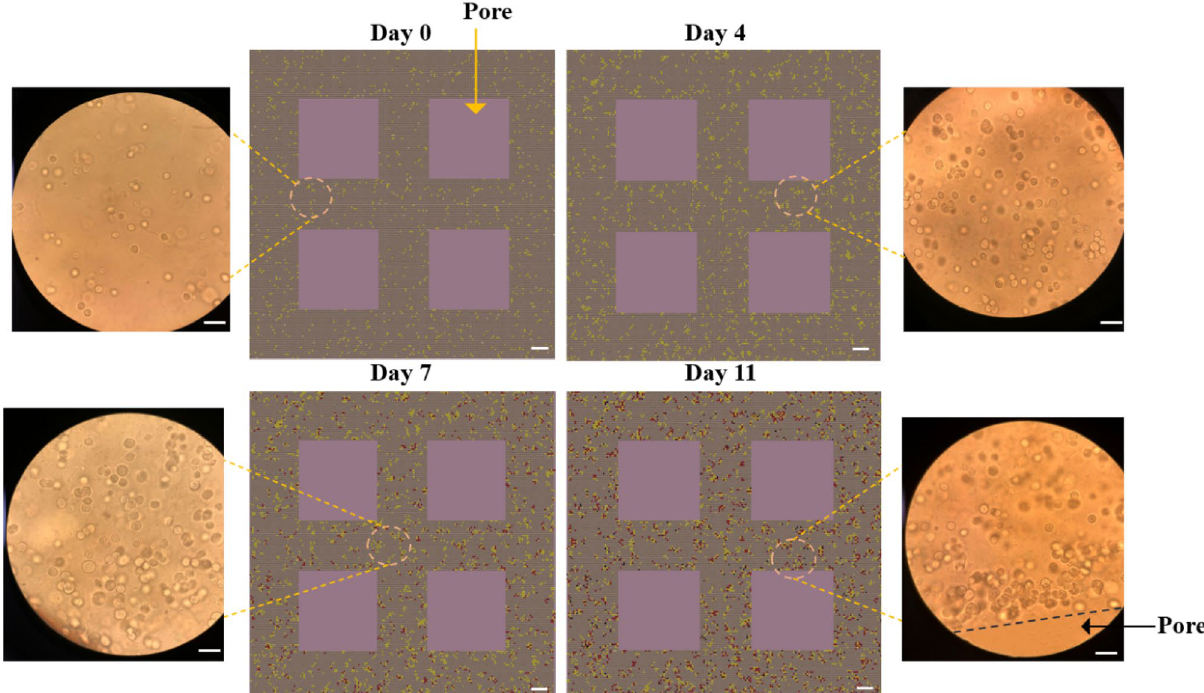
Figure 6. Middle panels visualize the MDA-MB-321 growth within the 3D hydrogel construct in silico; yellow represents proliferating cells; red represents non-proliferating cells; black represents dead cells. The right and left panels represent MDA-MB-231 cells encapsulated in 3D hydrogel constructs observed by a phase-contrast microscope on day 0, day 4, day 7, and day 11: scale bar, 50 μm.